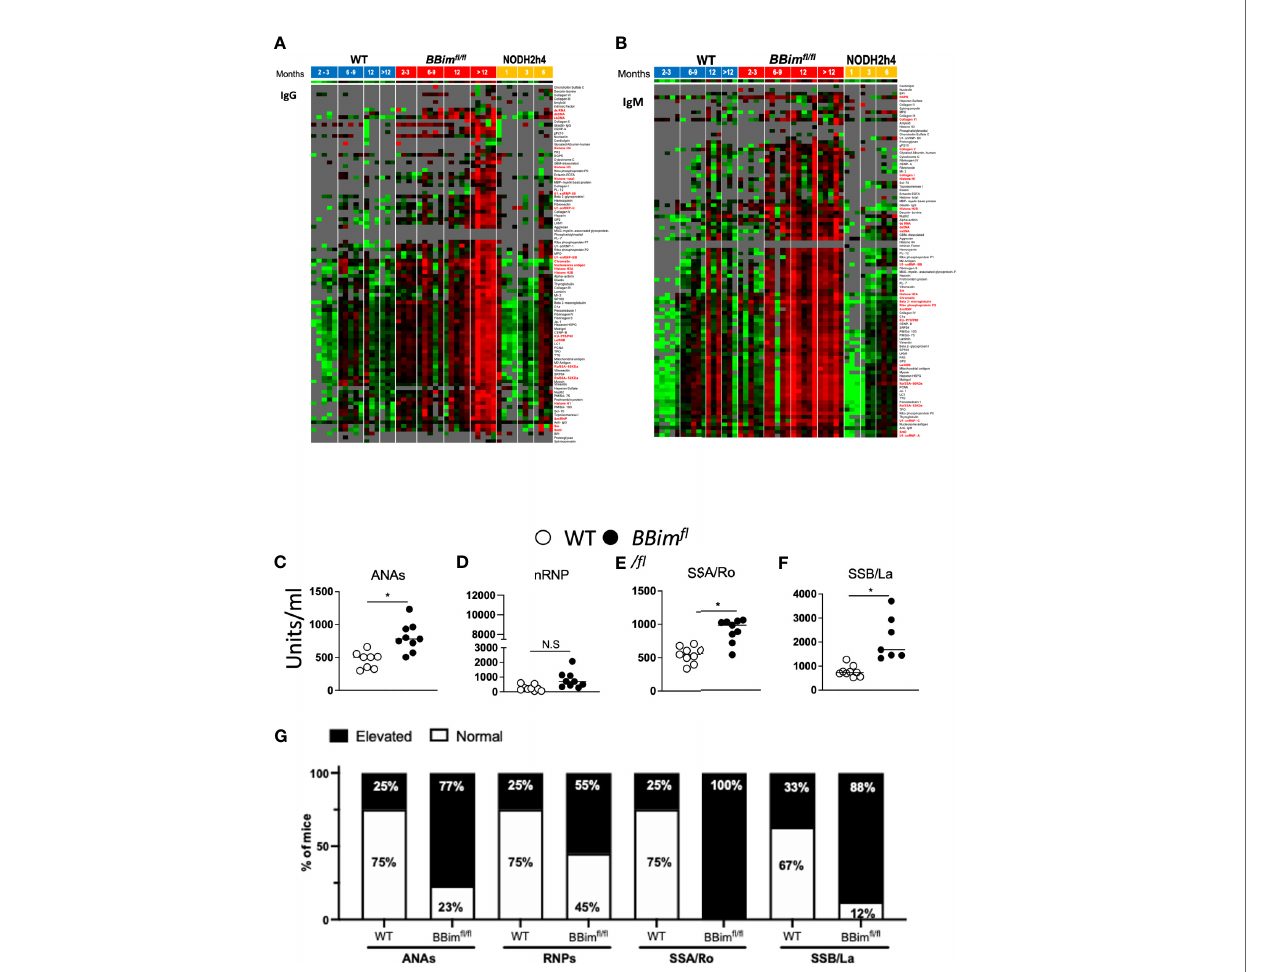
FIGURE 6 | BBim fl / fl mice exhibit elevated titers of SLE/SS signature autoAbs. Serum from mice of indicated age groups were screened for autoAbs by hybridizing to an array containing over 90 autoantigens. Each serum specimen was taken from a different mouse so each time point would be independent. Red boxes indicate greater reactivity than the average for each antigen and green boxes indicate lower reactivity than the average for each antigen. Reactivities close to the mean are displayed in black/gray. Some of the SS and SLE-associated autoAb names are highlighted in red. (A, B) Heat maps with clustering of WT (left), BBim fl / fl (middle) and NODH2h4 (right). Supervised clustering of autoAbs was performed with normalized signal intensities for baseline IgG and IgM autoAbs. (A) IgG and (B) IgM autoAbs showing higher reactivity (red) appeared in serum of BBim fl / fl mice by 6-9 months. At 12 months, additional IgM antibodies emerged and persisted, which were